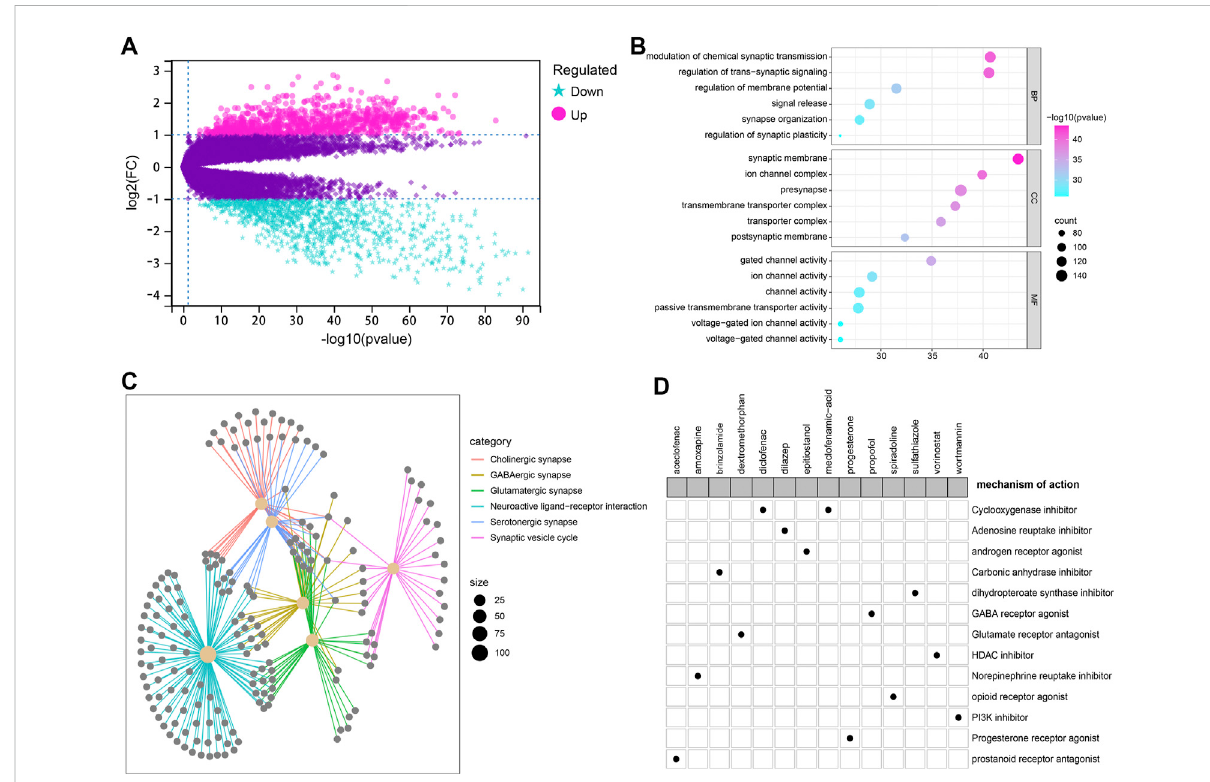
FIGURE 8 Potential small molecule compounds based on the glycosylation score. (A) Volcano plot showed 2090 DEGs between the high and low glycosylation score subgroups including 923 up- (red) and 1167 down-regulated (blue) genes. (B) Results of GO functional annotation for the DEGs, including biological process (BP), cellular component (CC), and molecular function (MF). (C) KEGG pathway enrichment analysis results showed the top six pathways ranked by the p -value. (D) CMap MoA analysis identi fi ed 13 mechanisms of action shared by 14 small therapeutic drugs potentially applicable for high glycosylation score